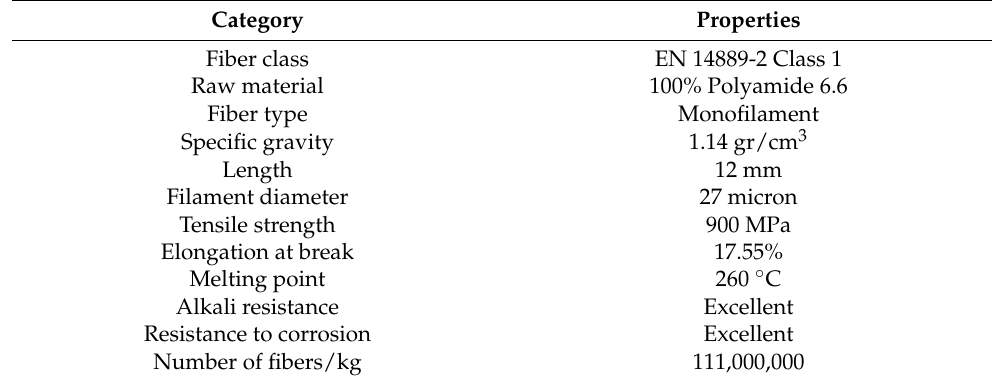
Figure 1. Monofilament micro-synthetic fibers. Table 1. Properties of micro-synthetic fiber [24].